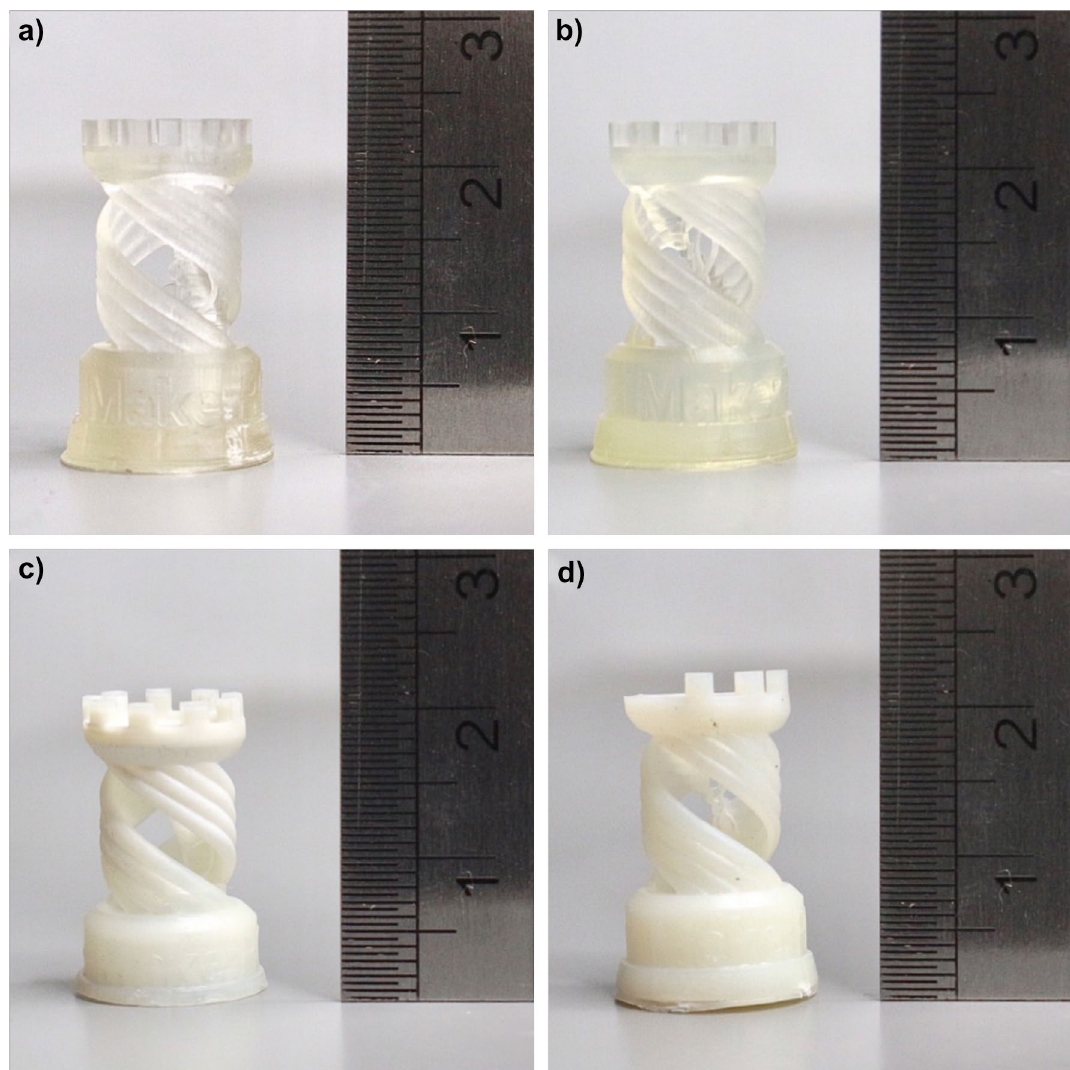
Figure 3. Photograph of the rock tower printed with UV-curable acrylate-based resin ( a ) and formulated UV-curable acrylate-based resins with 30%vol; ( b ) STDPPG430, ( c ) STDPPG1030, and ( d )